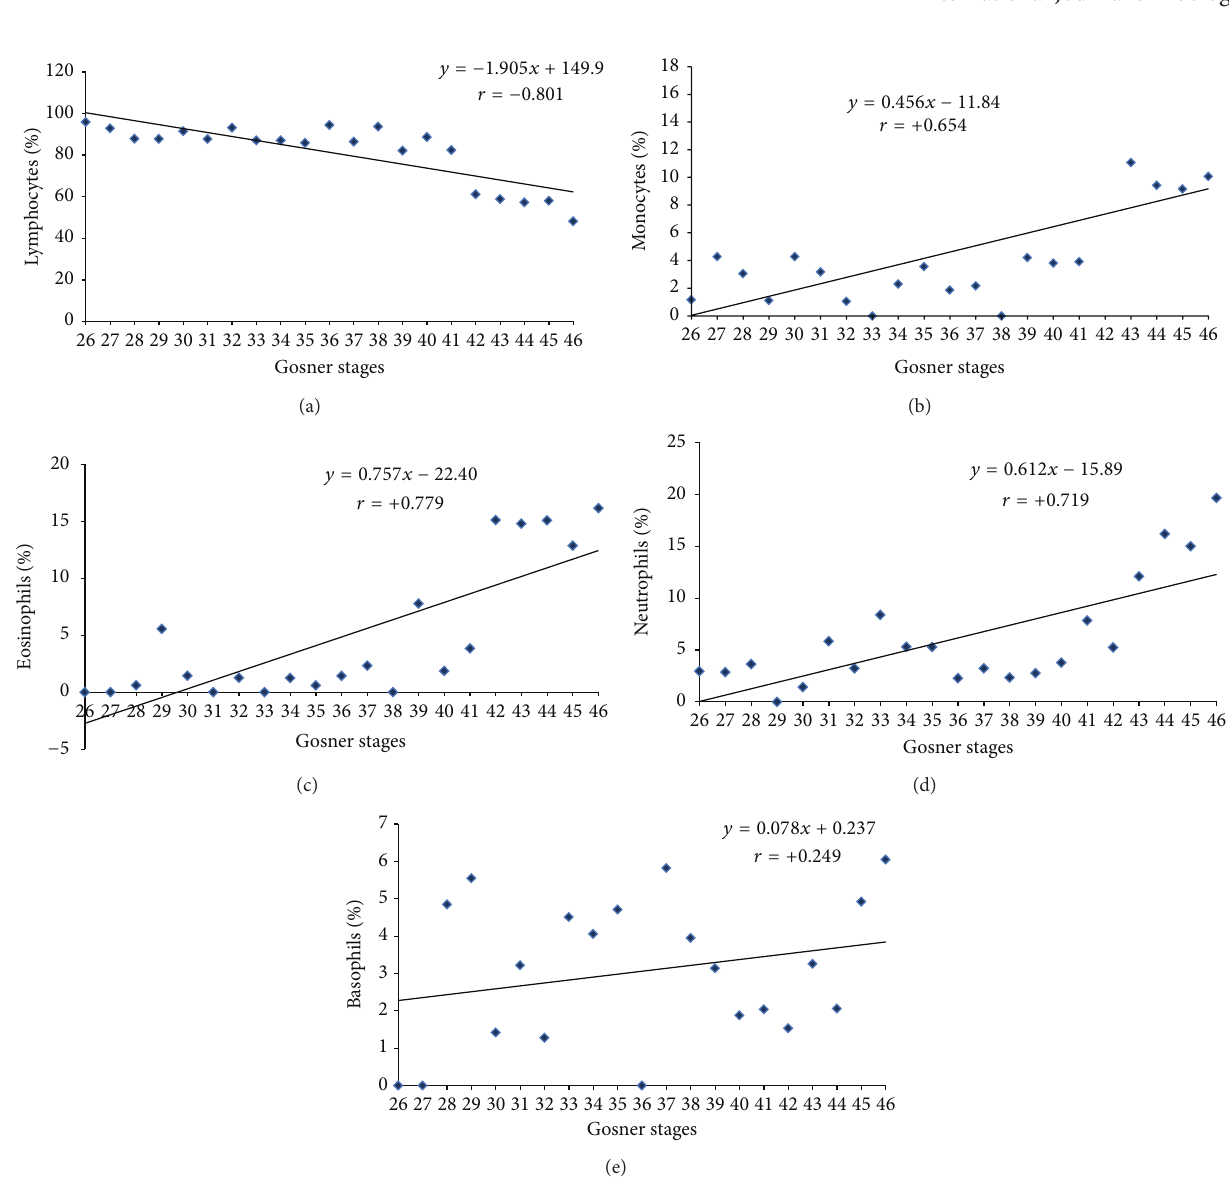
Figure 8: Correlation between the percentages of different types of leucocytes with respect to the developmental stages of the tadpoles of the ornate frog, Microhyla ornata